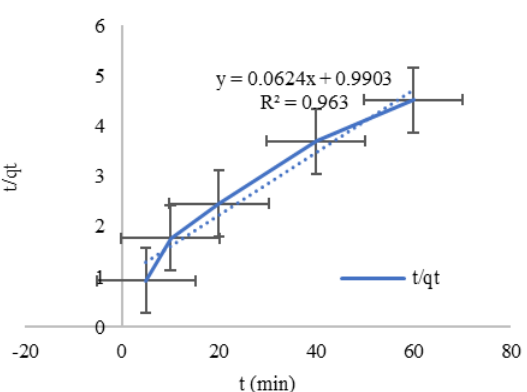
Fig. 8. Pseudo-second-order kinetics for removal of TNT in sono-Fenton